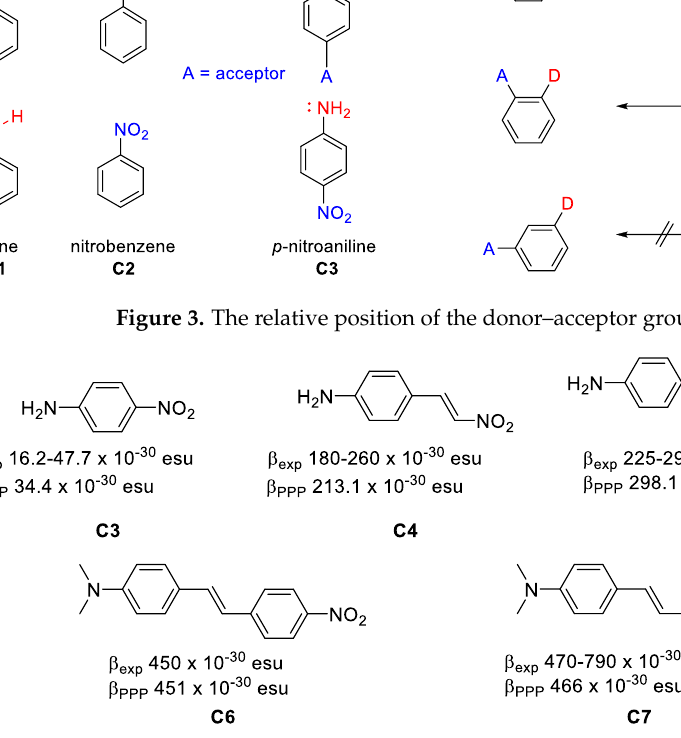
Figure 4. The effect of the length of the π system on the first-order hyperpolarizability.